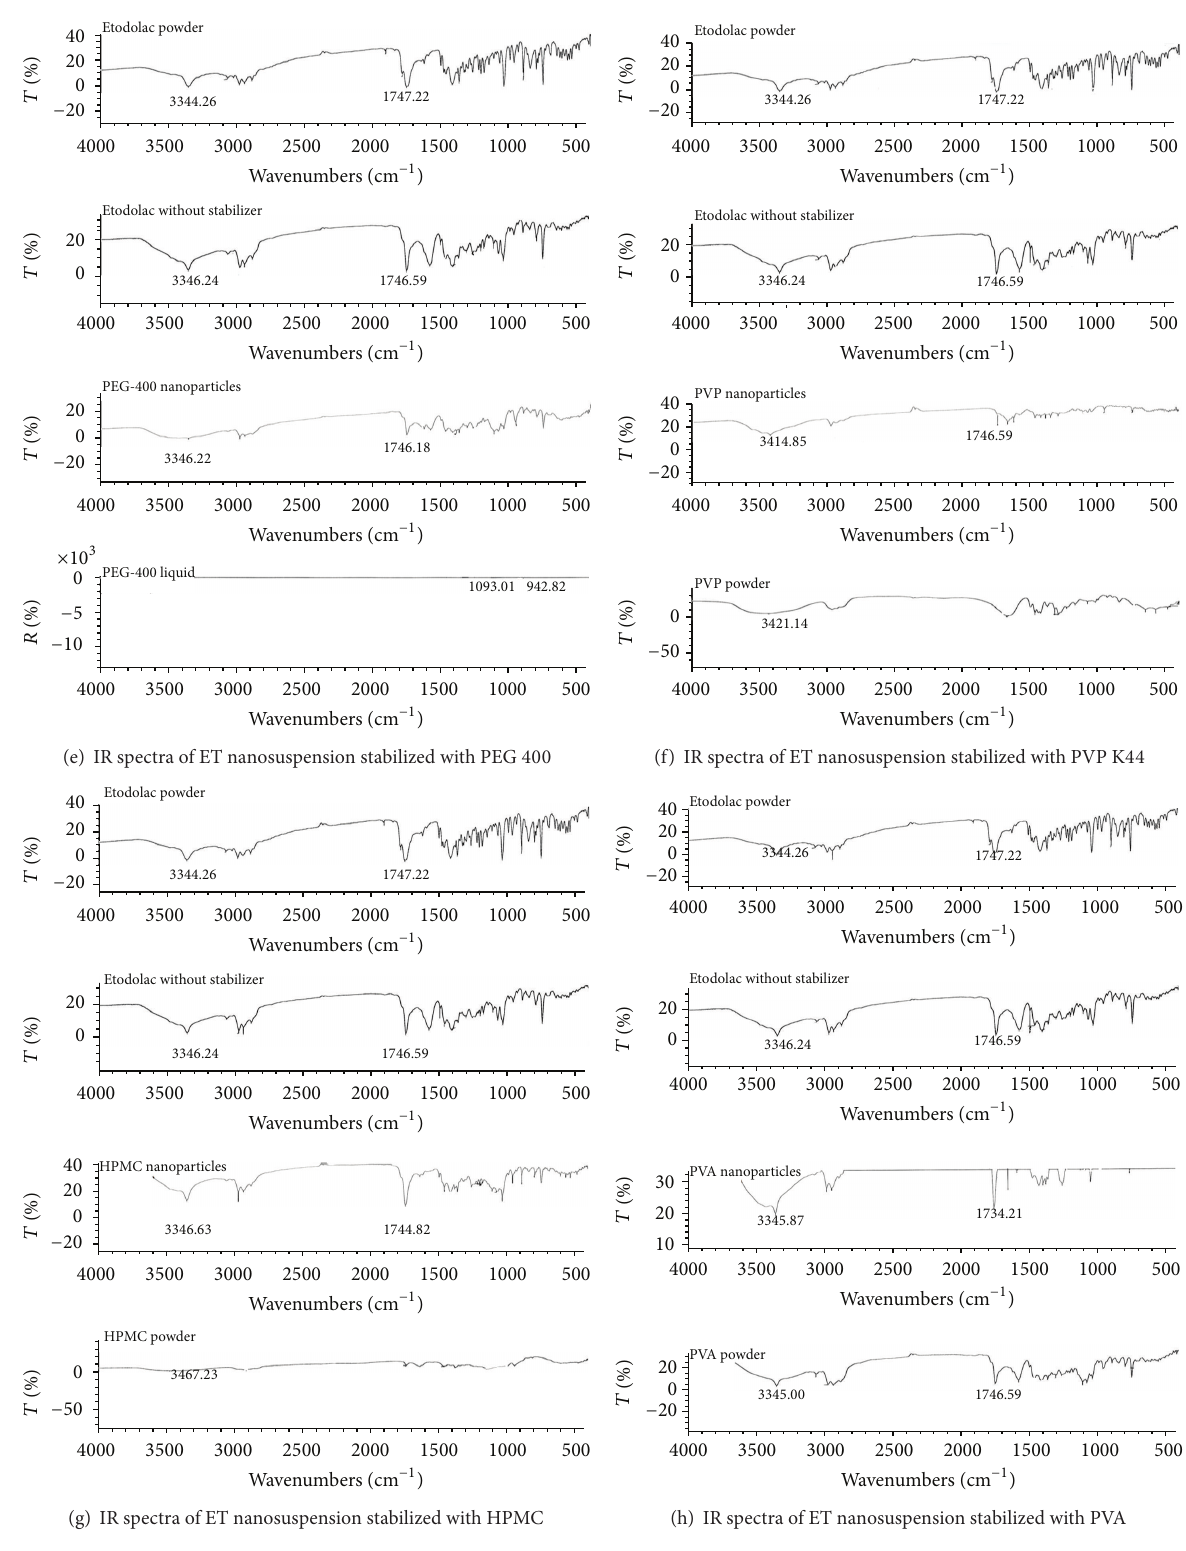
Figure 1: Fourier transformed infrared (FTIR) spectra of pure drug, drug nanosuspension, pure stabilizers, and all nanosuspensions